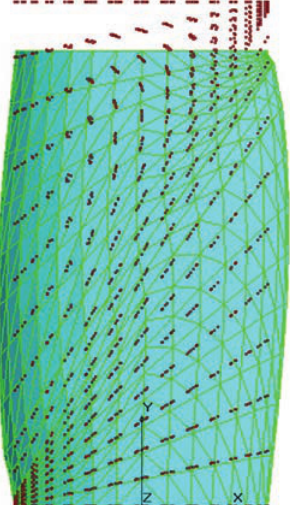
Fig. 11. Deformed shape of sample of triaxial test with fixed ends